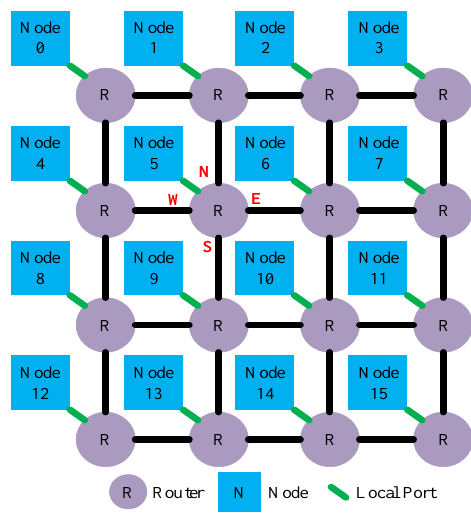
Figure 3. Generic 2D-mesh NoC topology.